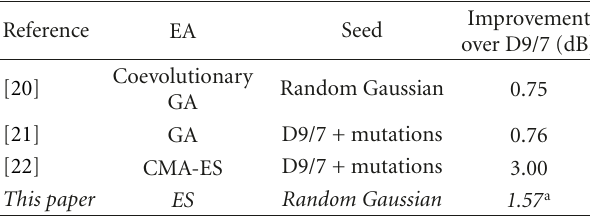
Table 13: Comparison of best evolved wavelet against state of the